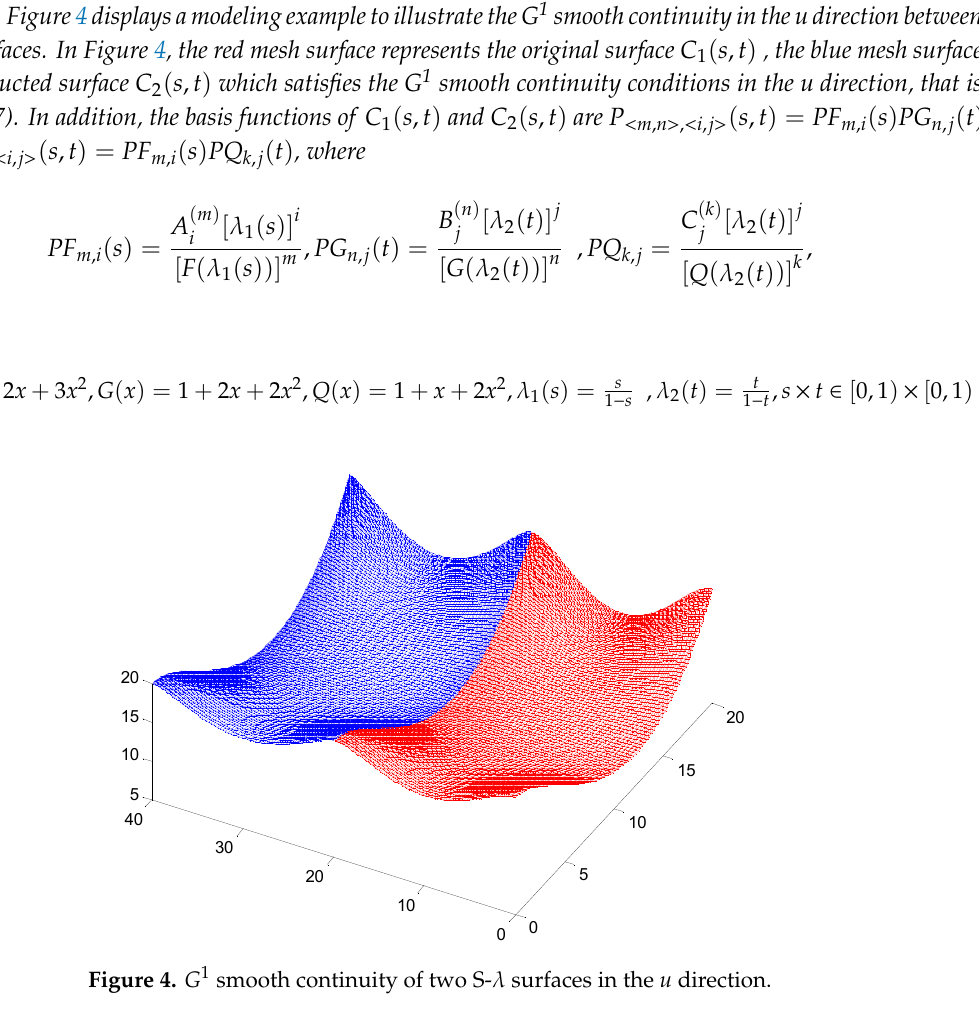
Figure 3. C 1 smooth continuity of S- λ curves.